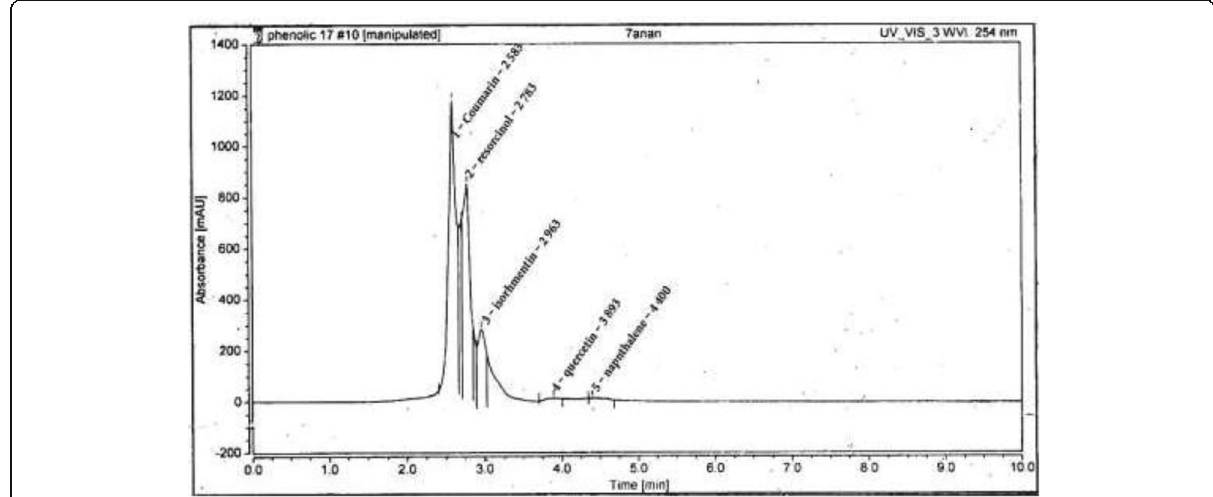
Fig. 2 HPLC chromatogram of the phenolic and flavonoid compounds of the P. angustifolia